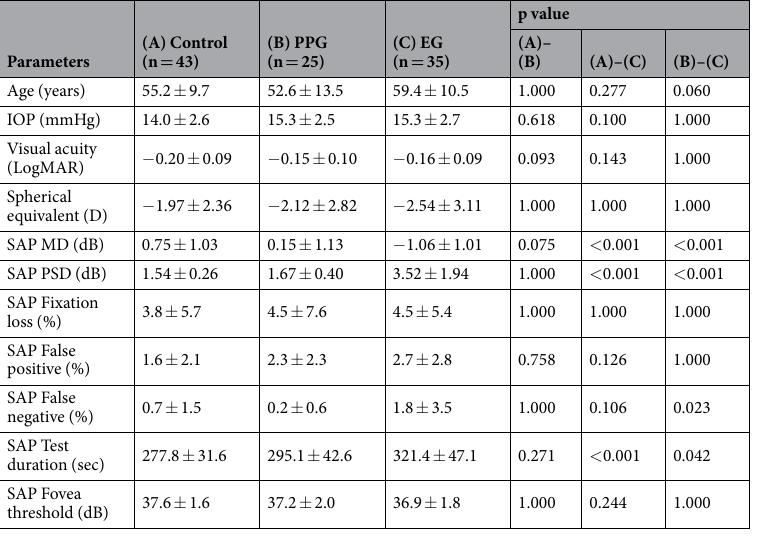
Table 1. Demographics of normal participants and glaucoma patients. PPG = pre-perimetric glaucoma; EG = early glaucoma; IOP = intra-ocular pressure; SAP = standard automated perimetry; MD = mean deviation; PSD = pattern standard deviation. Data are expressed as mean ± standard deviation. Statistical comparison was performed with Bonferroni